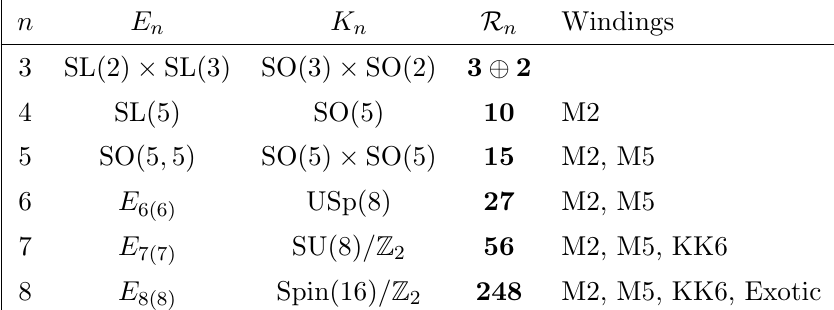
Table 1 . A selection of EFT symmetry groups E K n , coordinate representation R n and contributing windings of extended objects. The exotic objects will be discussed in more detail